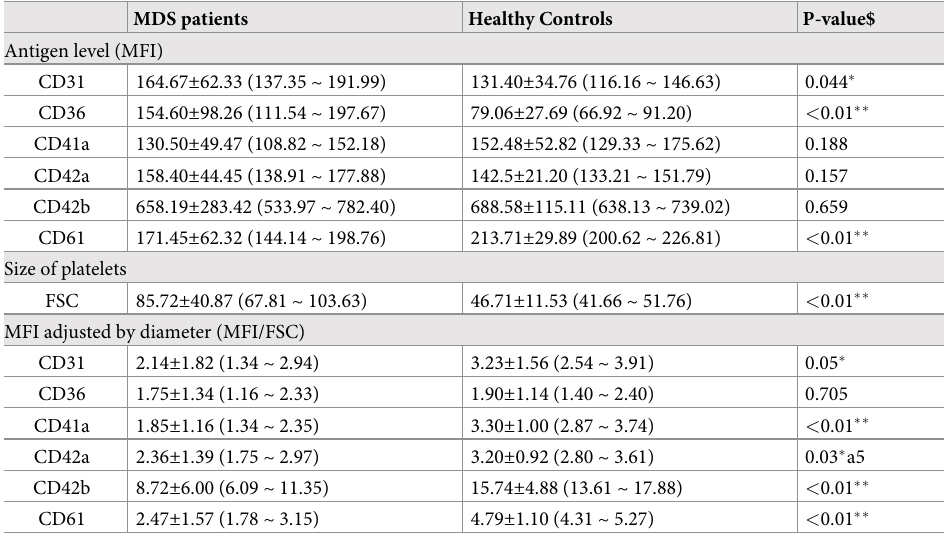
Table 2. Immunophenotypic characteristics of platelets in patients with myelodysplastic syndrome and healthy controls. MDS